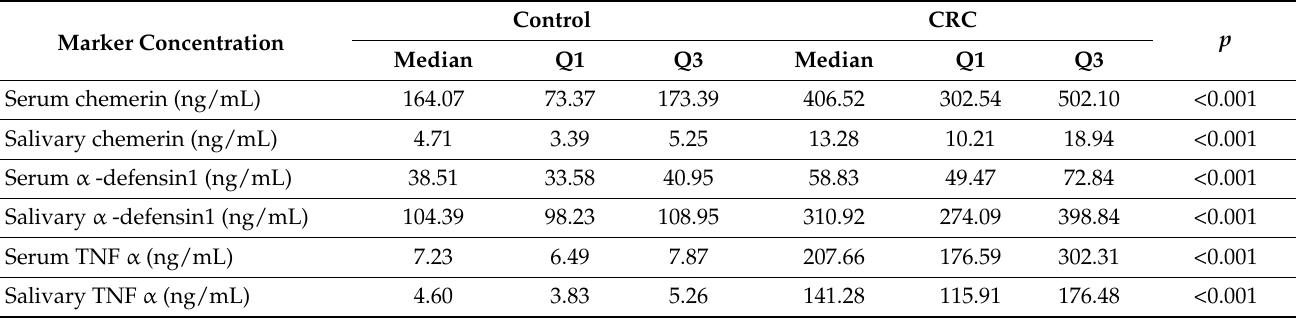
Table 2. Serum and salivary concentrations of chemerin, α -defensin 1 and TNF- α (ng/mL) in CRC patients and control group.